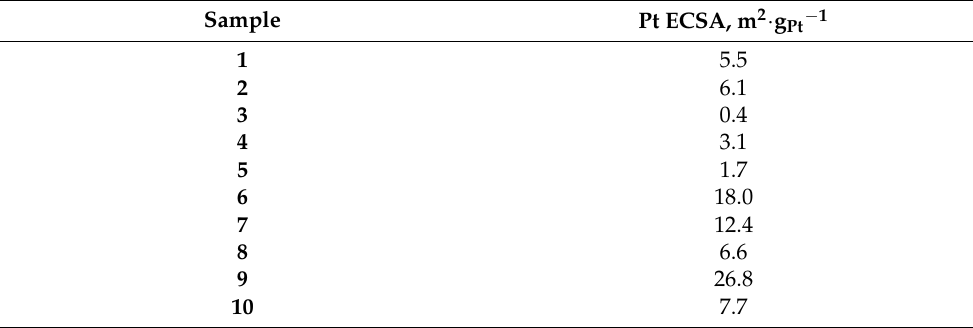
Table 5. ECSA of platinum for samples 1 – 10 .